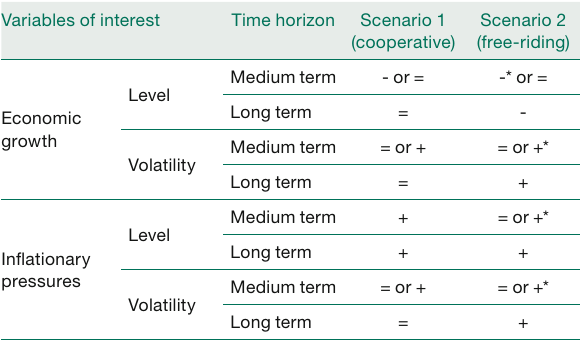
Possible impacts of climate